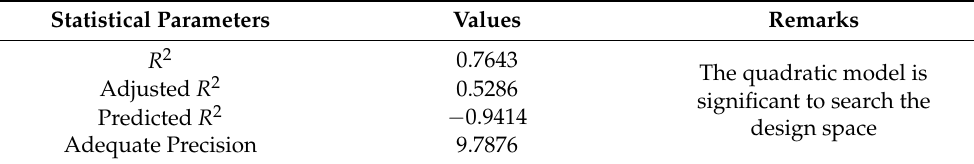
Table 5. Fit statistics for strain ( ε ).